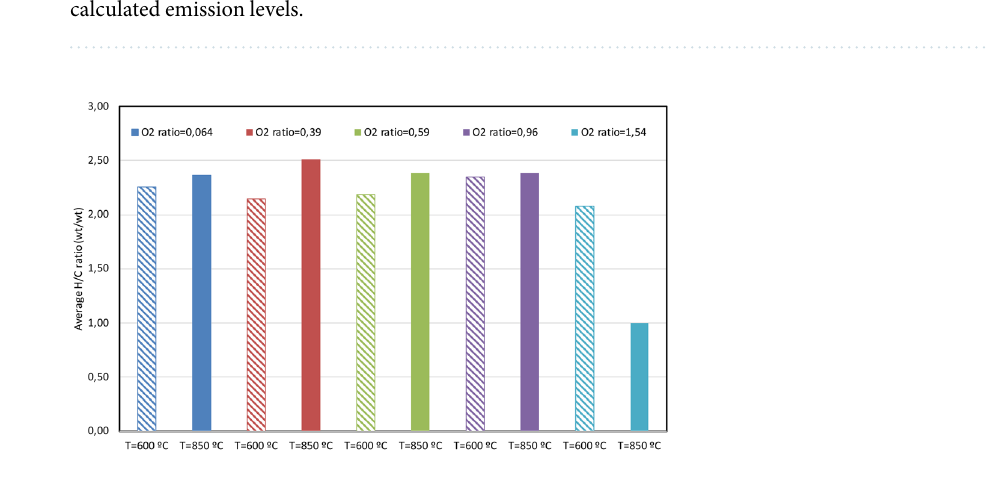
Figure 3. Evolution of the H/C ratio during ASR decomposition at different temperatures and oxygen